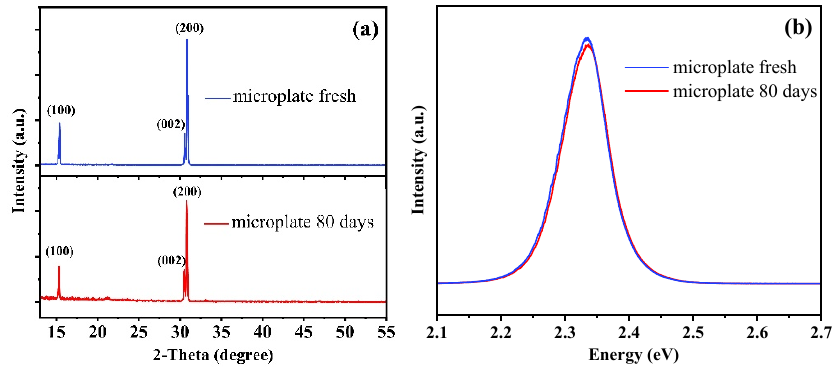
Figure 8. The PL spectra of the CsPbBr 3 microplate, frustum of a square pyramid, and pyramid. Figure 9. Cont